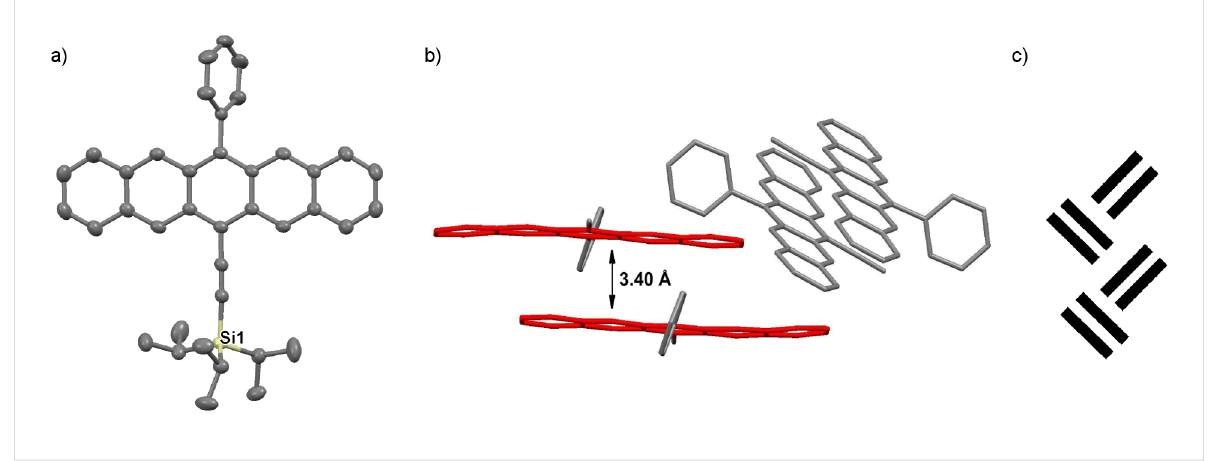
Figure 5: X-ray crystallographic analysis of 3a showing a) molecular structure and b) packing motif (triisopropylsilyl groups omitted for clarity); ORTEP drawn at 50% probability level. c) Schematic representation of “sandwich herringbone” packing arrangement.